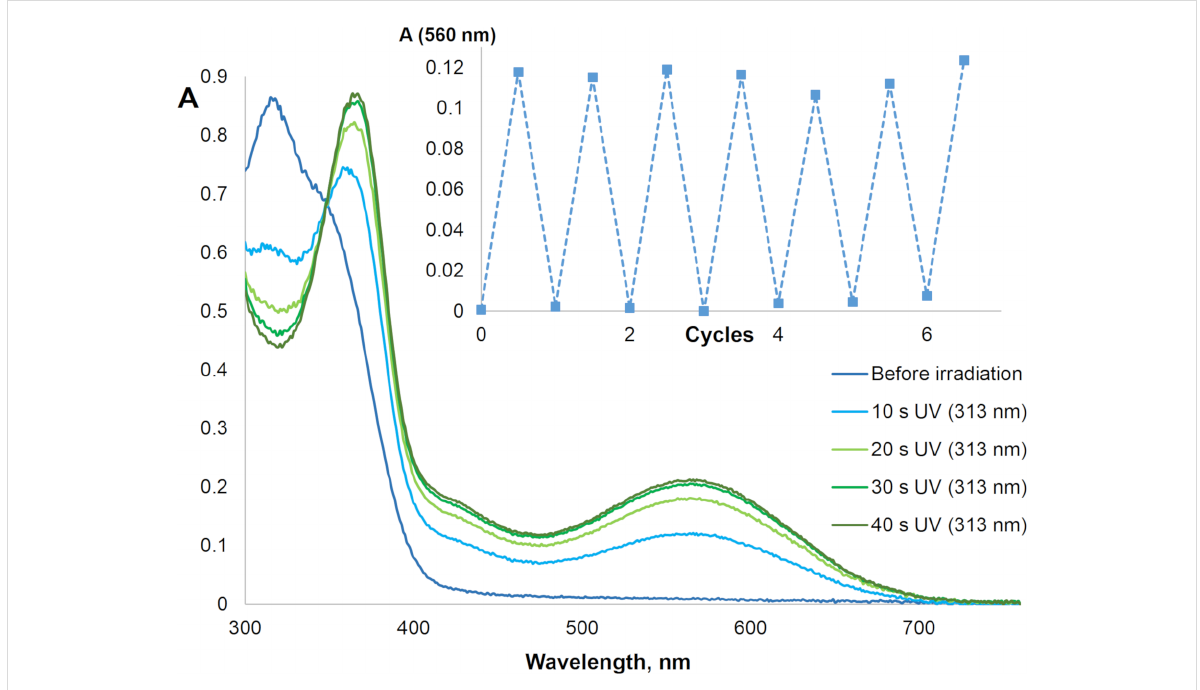
Figure 2: Electronic spectra of diarylethene 6 upon UV irradiation (313 nm, toluene, c = 3.4 × 10 − 5 M). Inset: fatigue resistance upon multiple subse- quent irradiation with UV (365 nm) and visible light (green LED) in